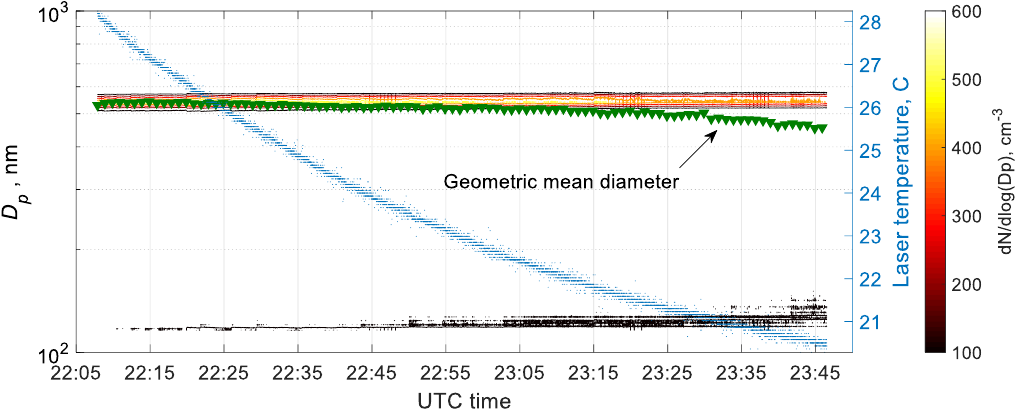
Figure 8. The optical laser temperature effect on the size distribution measurement for the 500 nm PSL aerosol particles.